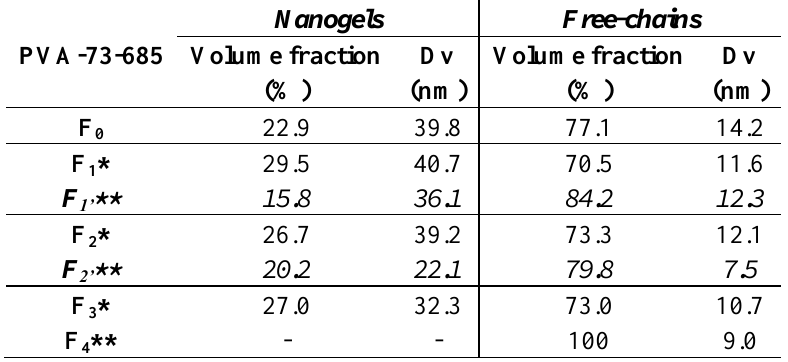
Table 3. Volume fraction and size average (Dv) of nanogels and “free chains” of different PVA-73-685 fractions at a concentration of a 1